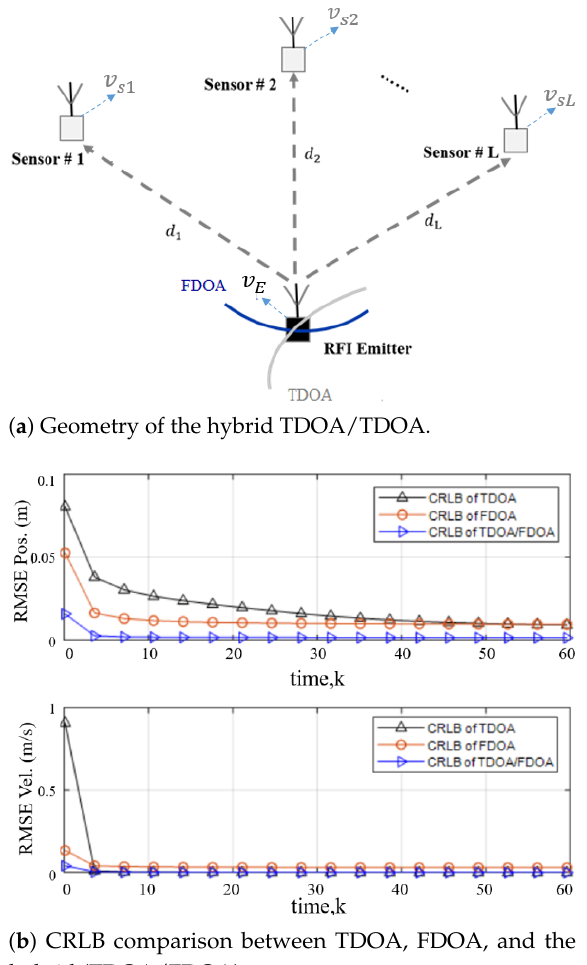
Figure 9. The geometry and Performance verification of hybrid TDOA/FDOA measurements compared to TDOA and FDOA individually